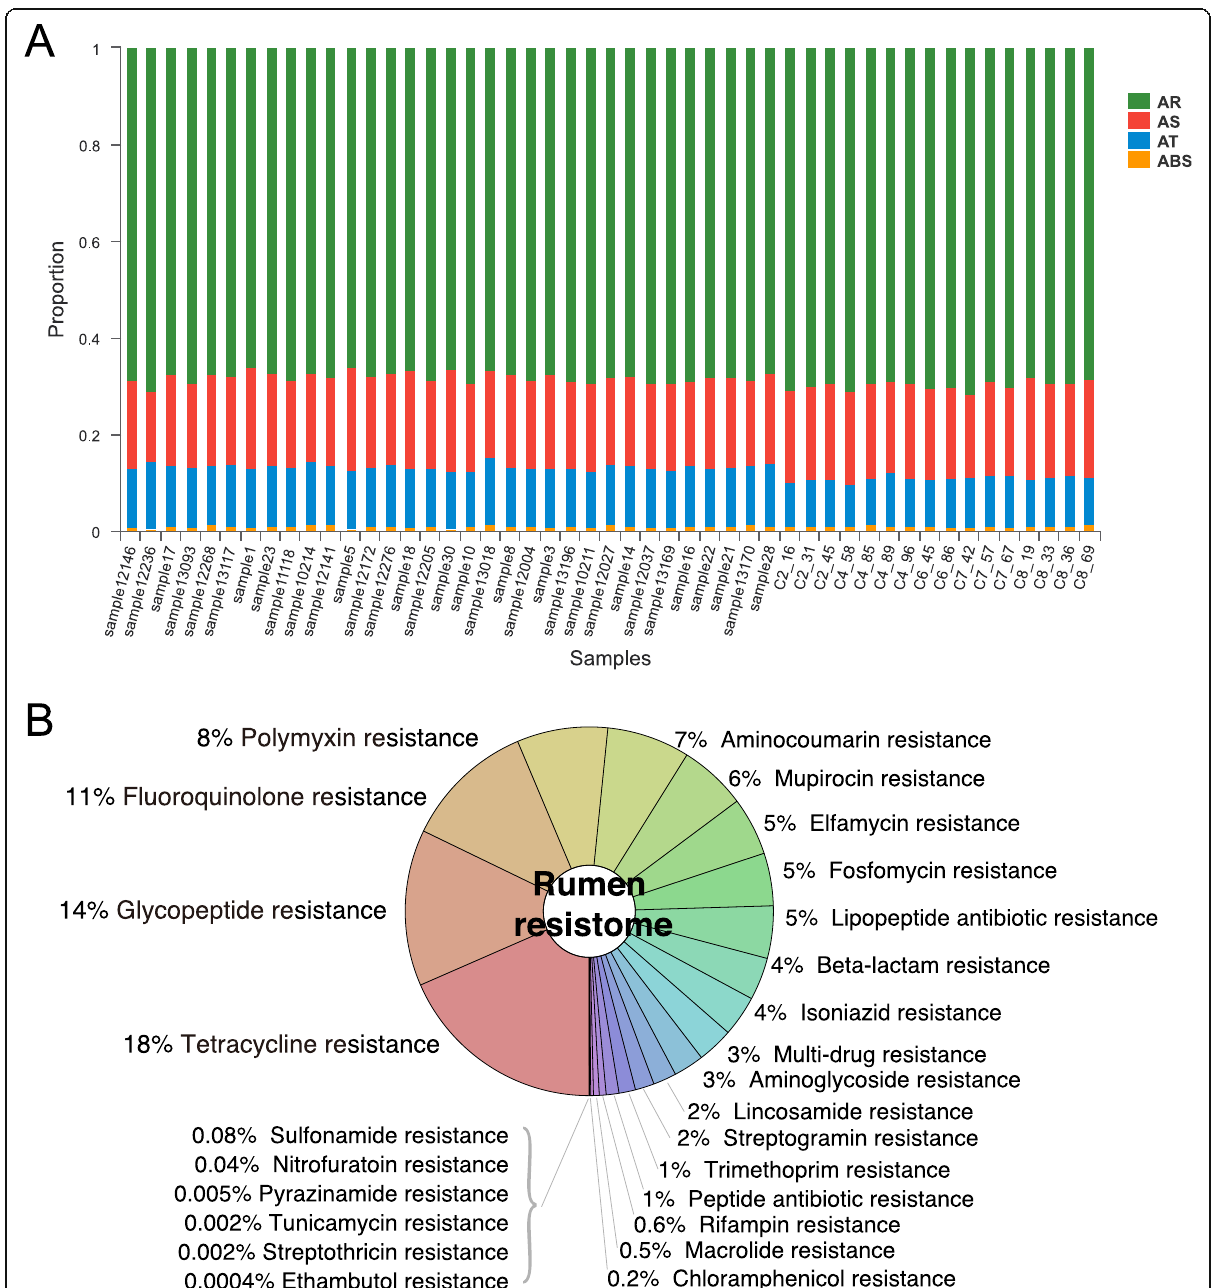
Fig. 1 Composition of ruminal resistome in dairy cows. a Abundances of ARGs (antimicrobial resistance genes) per branch. ABS, Antimicrobial Biosynthesis; AT, Antimicrobial Target; AS, Antimicrobial Sensitive; AR, Antimicrobial Resistance. b Ruminal resistome composition summarized at the antimicrobial-class